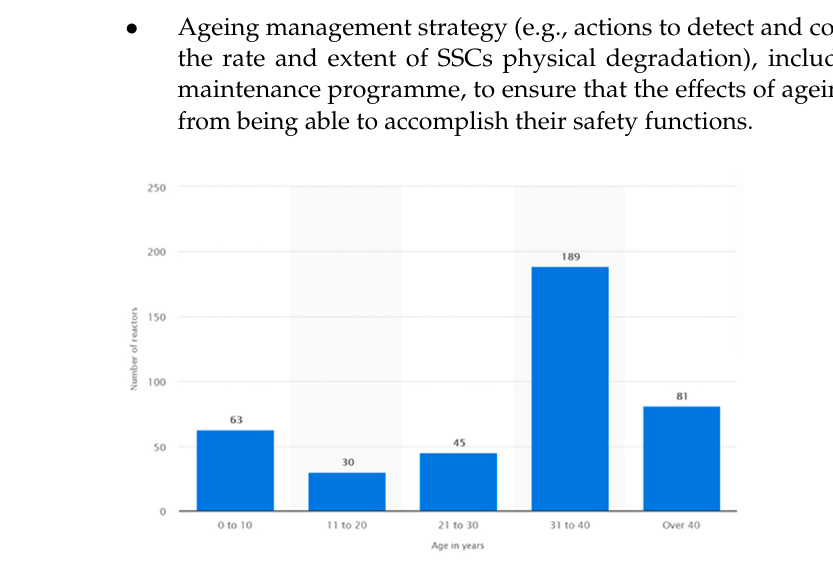
Figure 1. Number of operating NPPs by average age worldwide as of July 2020 [1].